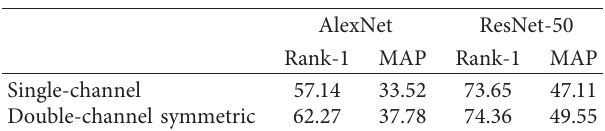
Figure 1: Illustration of double-channel symmetry CNN architecture. Table 1: The comparison between single-channel and double- channel